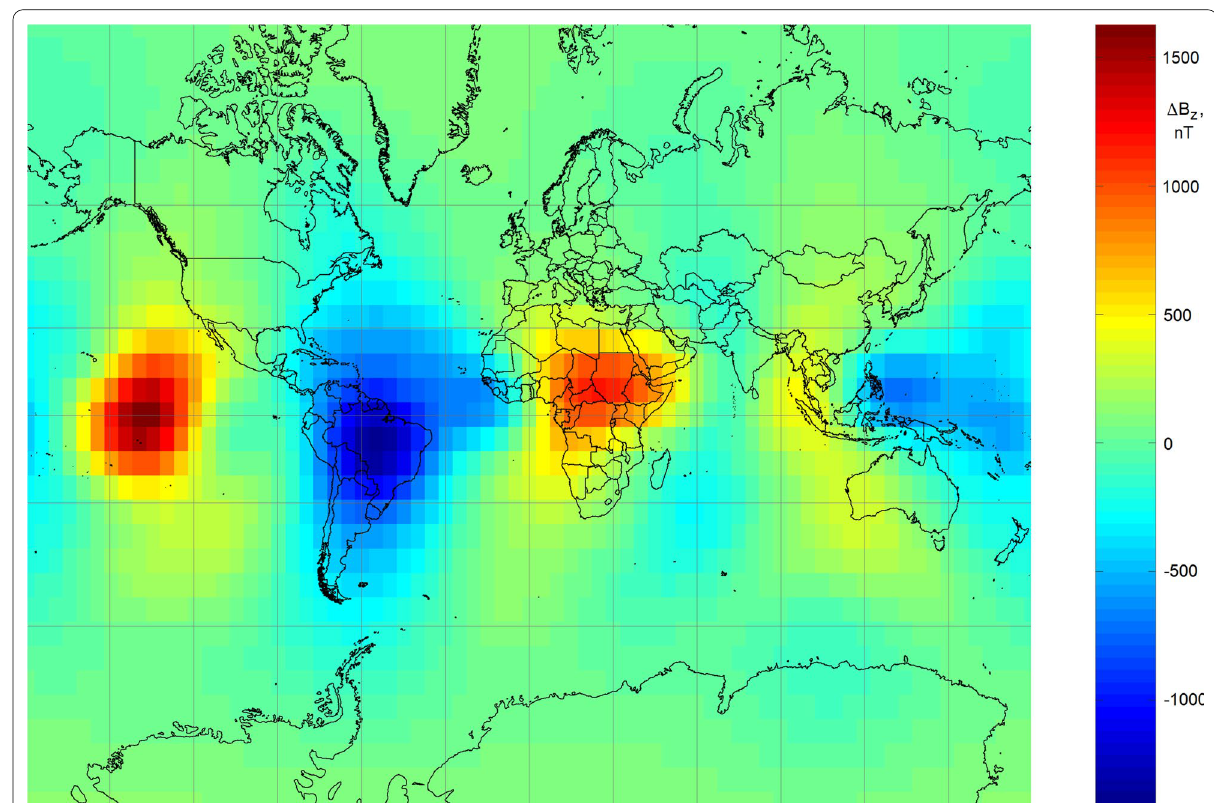
Fig. 5 Comparison of the model based on Kosmos-321 data (M-2) with the IGRF model as a map of Z component differences calculated at the nodes of the regular geographic grid at a spherical surface with the mean Earth radius, 6371.2